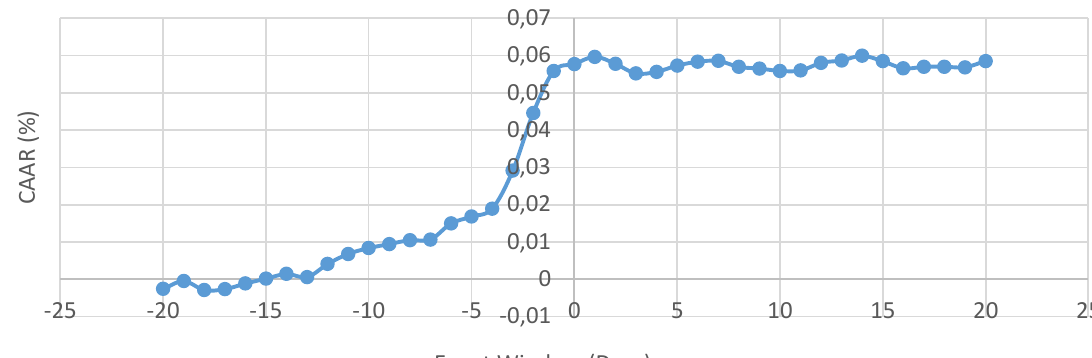
Figure 2. Average abnormal returns for 41 days